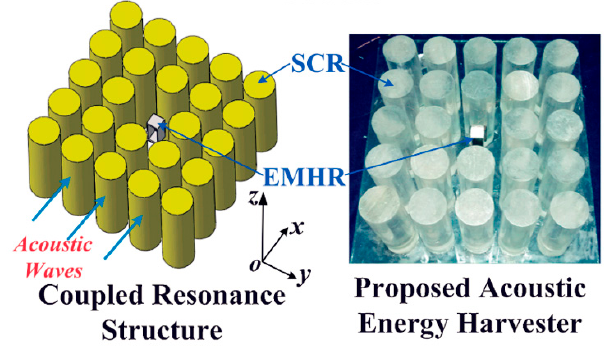
Figure 17. Coupled AEH system consisting of a sonic crystal resonator (SCR) and electromechanical Helmholtz resonator (EMHR). Reproduced with permission from [55]; published by the Japan Society of Applied Physics, 2016.